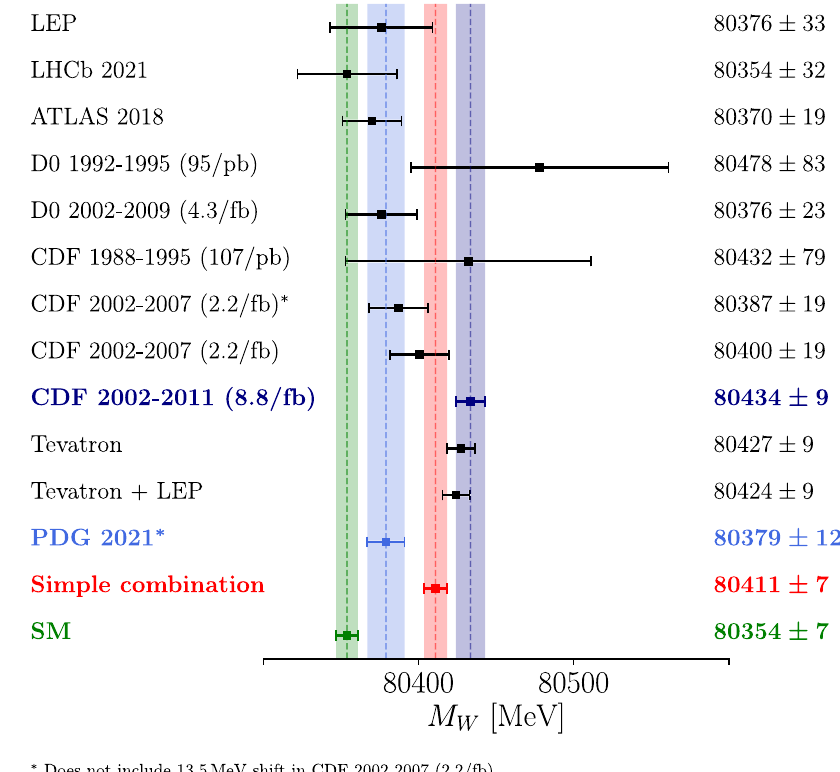
Fig. 1 | Simple combination of M W measured by different experiments. Mea- surementsofthe W bosonmassfromLEP 105 ,LHCb 106 ,ATLAS 107 ,D0 108 andCDFIand II 1,31,109 . We show an SM prediction 66 , the previous PDG combination of measurements 110 , CDF combinations of Tevatron and LEP measurements 1 , and a